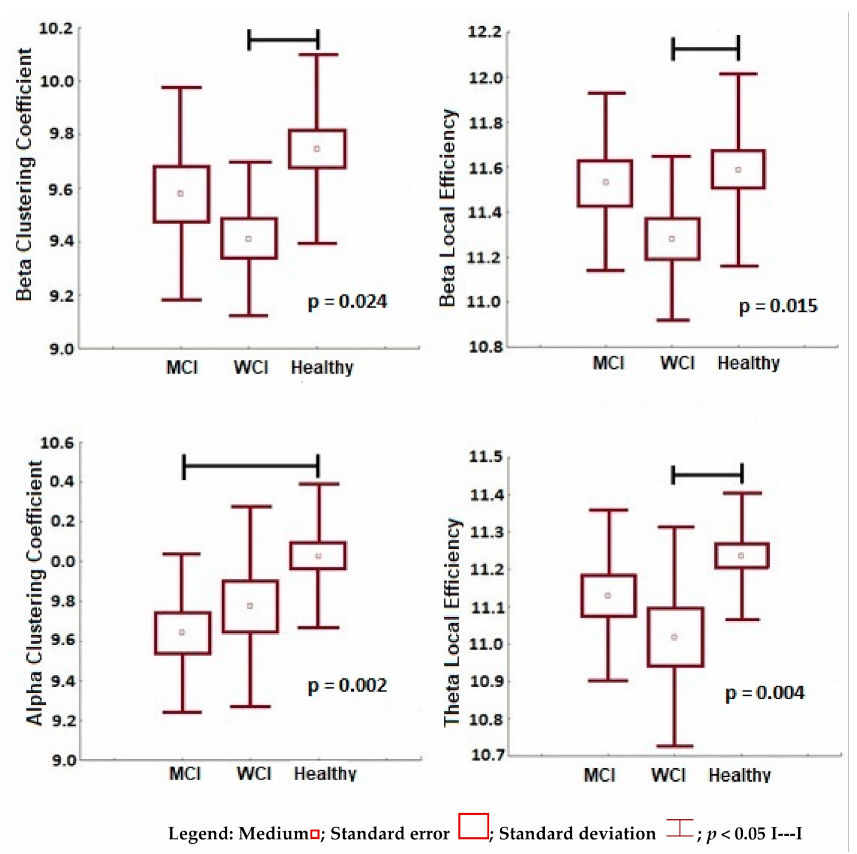
Figure 2. Functional segregation variables (beta clustering coefficient, beta local efficiency, alpha clustering coefficient, theta local efficiency) with significant differences between the groups (healthy subjects, PD-WCI, PD-MCI). Mann–Whitney U, significance value p <